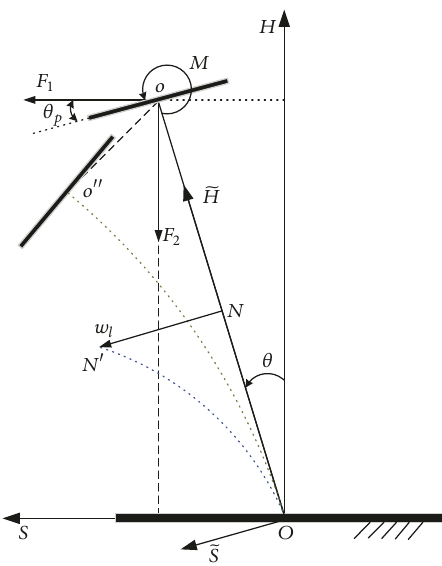
Figure 7: Deformation principle and force equivalent.